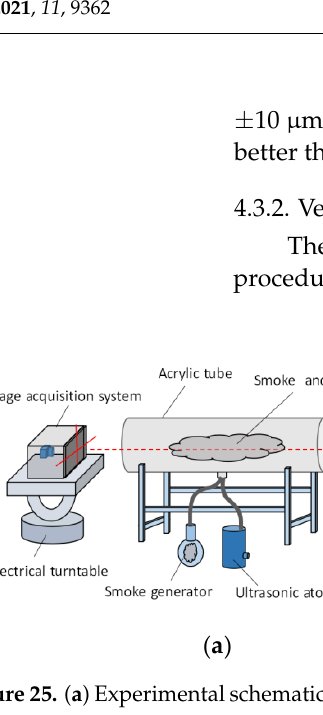
Figure 24. Displacement error distribution after compensation under smoke and water mist envi-